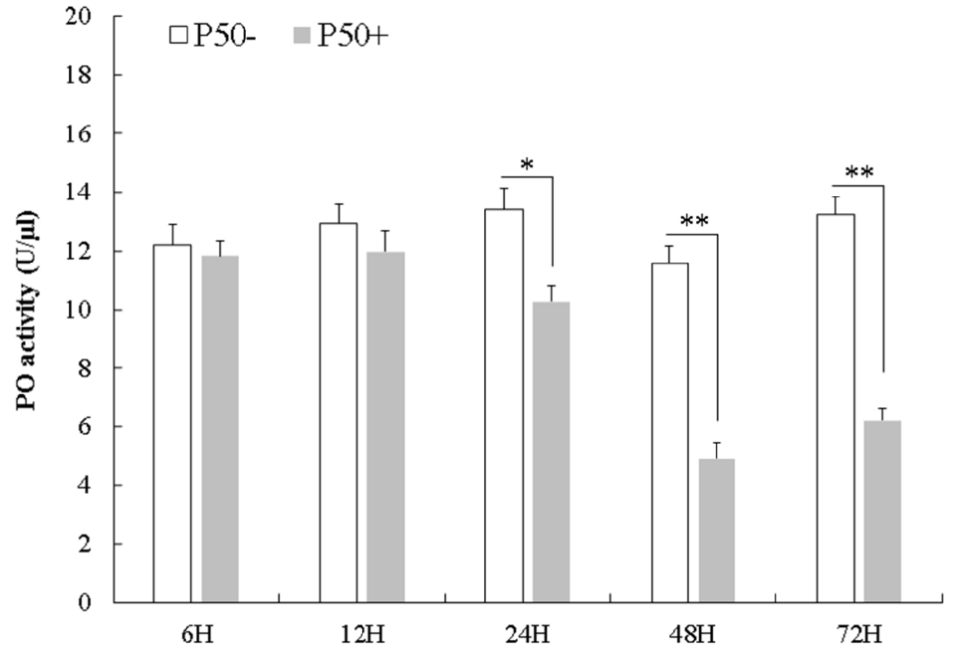
Figure 7. Phenoloxidase (PO) activity of cell-free haemolymph in control and infected B. mori at 6, 12, 24, 48 and 72 hpi. Error bars show mean ± SD ( n = 3). Statistical analysis was performed using SPSS software. Significant differences are indicated by * ( p < 0.05) or ** ( p < 0.01).